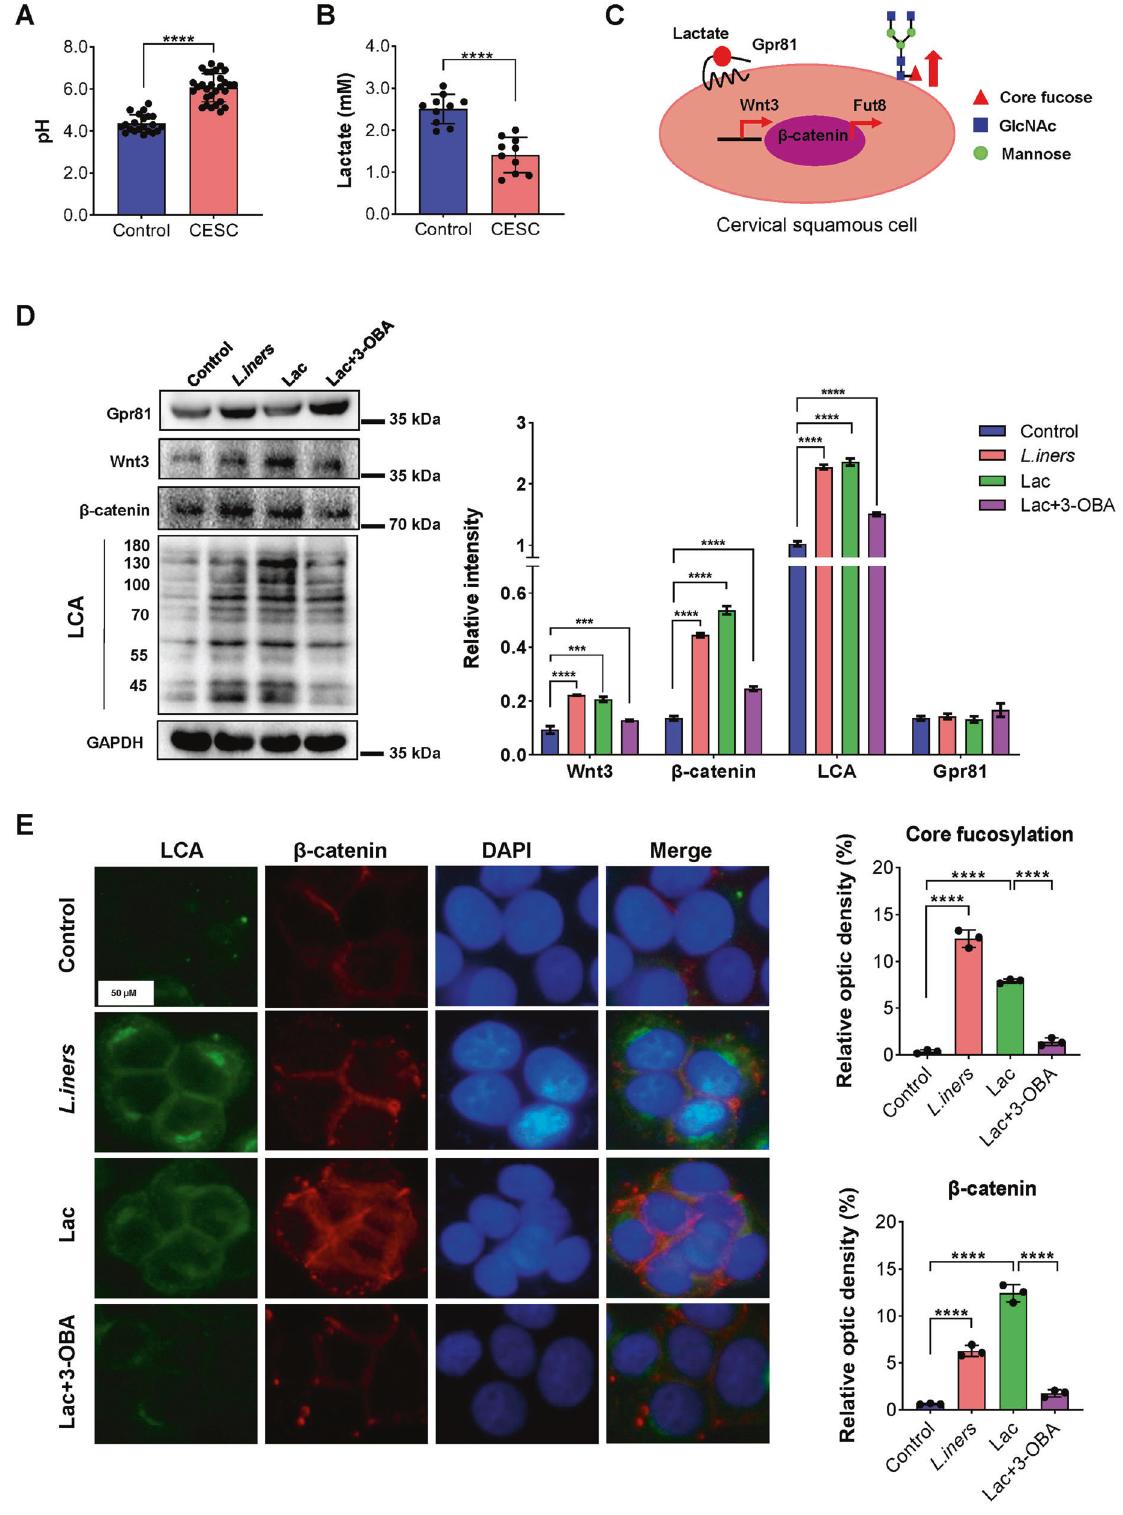
Fig. 6 The L. iners metabolite lactate activates the Wnt pathway through the lactate-Gpr81 complex to increase the core fucosylation of epidermal cells. A Comparison of vaginal pH in healthy volunteers and cervical cancer patients. B Comparison of vaginal lactate levels in the two groups. C Schematic diagram of the effect of lactate. D After SiHa cells were treated with L. iners metabolites, lactate and lactate and 3- OBA, the level of core fucosylation and expression of β -catenin, wnt3, and Gpr81 were determined. E Cellular immuno fl uorescence experiments were used to analyze the level of core fucosylation and expression of β -catenin after SiHa cells were treated with L. iners metabolites, lactate and lactate and 3-OBA. *** p < 0.001, **** p < 0.0001.